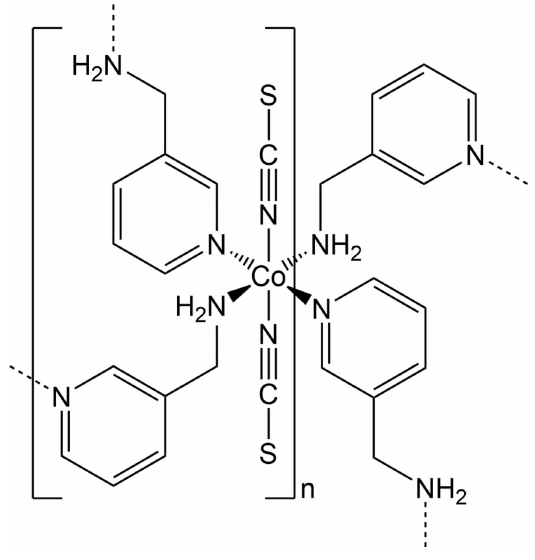
Figure 1 Crystal structure of the title compound with labeling and displacement ellipsoids drawn at the 50% probability level. Symmetry codes: A = (cid:3) x , (cid:3) y + 1, (cid:3) z , B = 1 Co (red), N (blue) and S